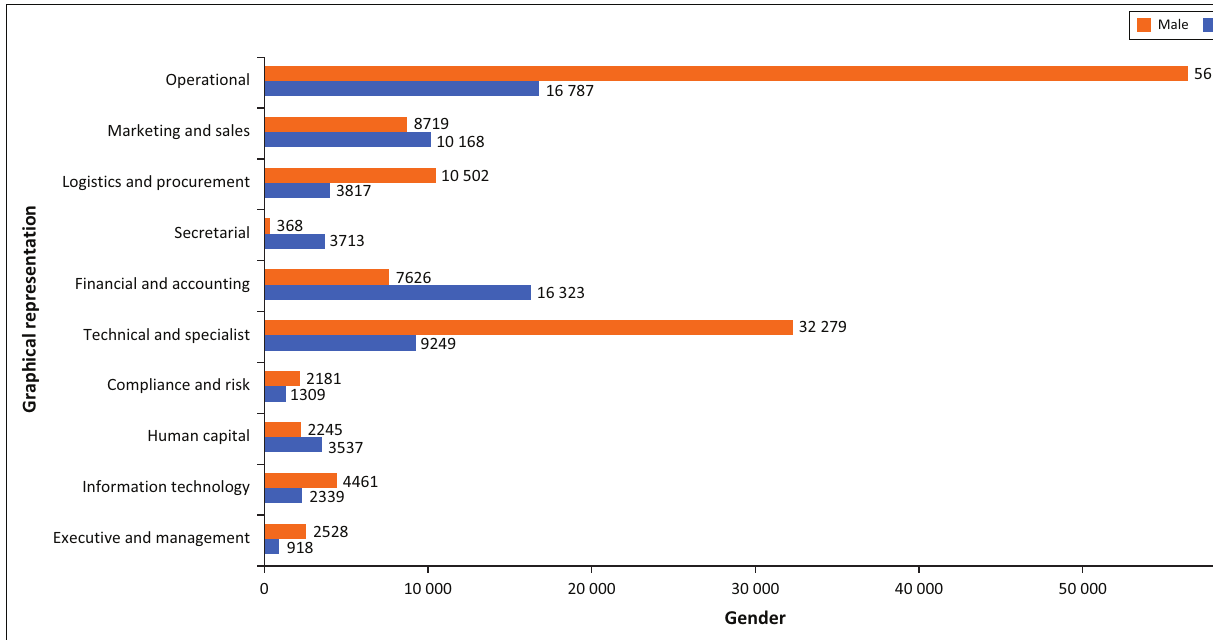
FIGURE 1: Study sample distribution graphical